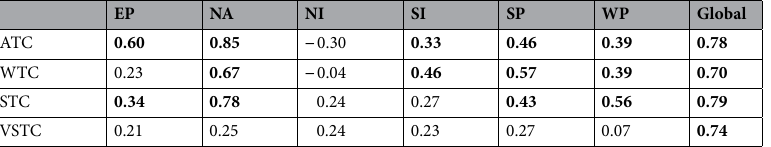
Table 4. Correlation coefficient of significant trends at α = 0.05.